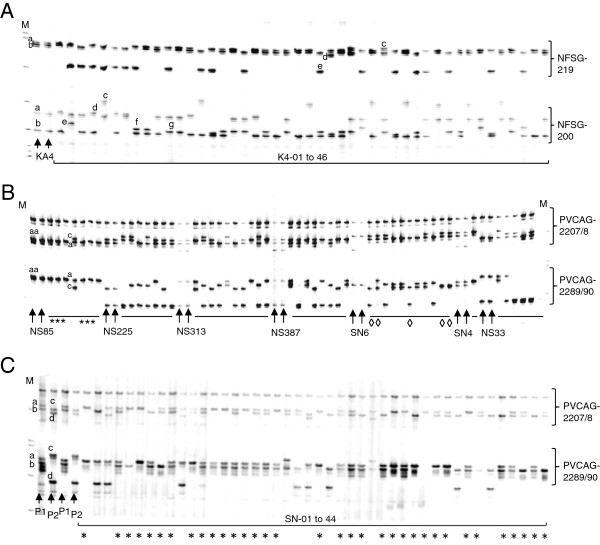
Genotyping switchgrass progeny with duplex PCR. For each parent, DNA sample was duplicated in PCR and shown by arrows. The letters (“a” to “g”) indicate different alleles of each locus. “M” indicates the DNA ladder. A) Genotyping a maternal plant (K4) grown in a field plot and its 46 progeny (K4-01 to 46) with a duplex set 9 (NFSG-200 and NFSG-219). B) Genotyping seven parents (arrows) and their progeny harvested by bagging in the field with duplex set 12 (PVCAG-2207/8 and PVCAG-2289/90). The asterisks indicate selfed progeny and lozenges indicate seed contaminations. C) Genotyping the seed parent ‘SL937x15’ (P1), pollen parent ‘NL94 LYE 16x13’ (P2) and 44 progeny (SN-01 to 44) amplified with a duplex set 12. The asterisks indicate selfed progeny.